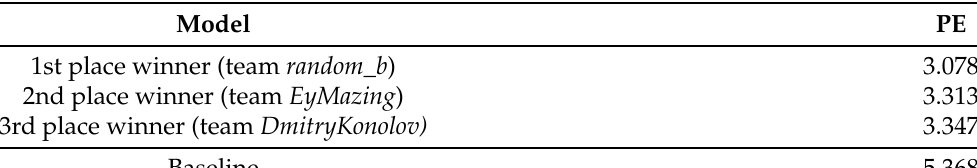
Table 6. Performance numbers from the top-3 winning entries to the OpenEDS 2020 Gaze Prediction challenge, reported in terms of Prediction Error, in